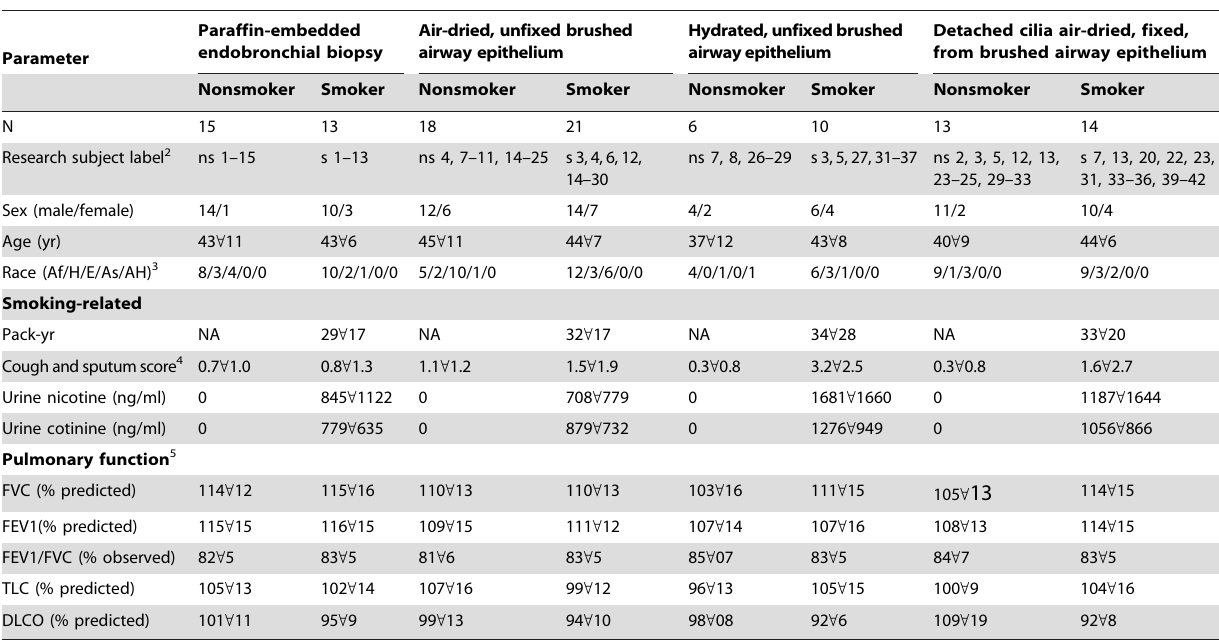
Table 1. Study Population for Cilia Length Measurements 1